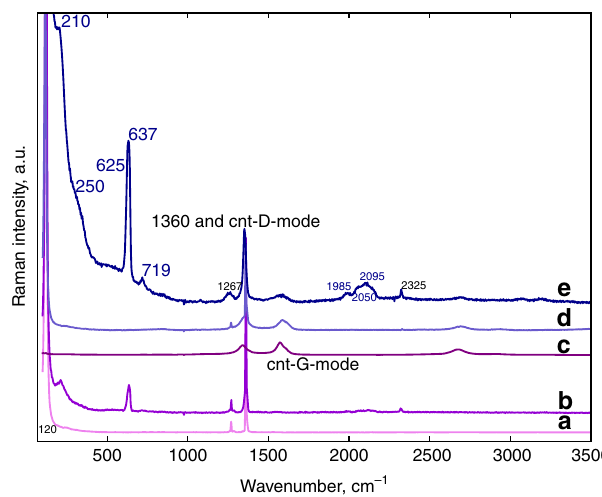
Fig. 1 Raman spectra (532 nm) of the samples before and after plasma reaction. Spectra a , b are from free-standing NaN 3 before and after plasma reaction, respectively; spectra d , e are from NaN 3 deposited from sodium azide solution on short carbon nanotubes before and after plasma reaction, respectively, and spectrum c is from as-received short carbon nanotubes. NaN 3 has three Raman active modes: the symmetric stretching ν 1 mode of the azide ion at 1360 cm − 1 , the librational lattice mode at 120 cm − 1 and the fi rst overtone of the IR active bending ν 2 mode of the azide ion at 1267 cm − 1 . The 1360 cm − 1 line from the azide ion overlaps with the carbon nanotube D (defect) mode. The carbon nanotube G (graphitic) mode is at 1585 cm − 1 , the sharp line at 2325 cm − 1 in the plasma-reacted samples may be attributed to nitrogen trapped in the short nanotubes and in sodium azide, and the line at 2620 cm − 1 is the carbon nanotube 2D